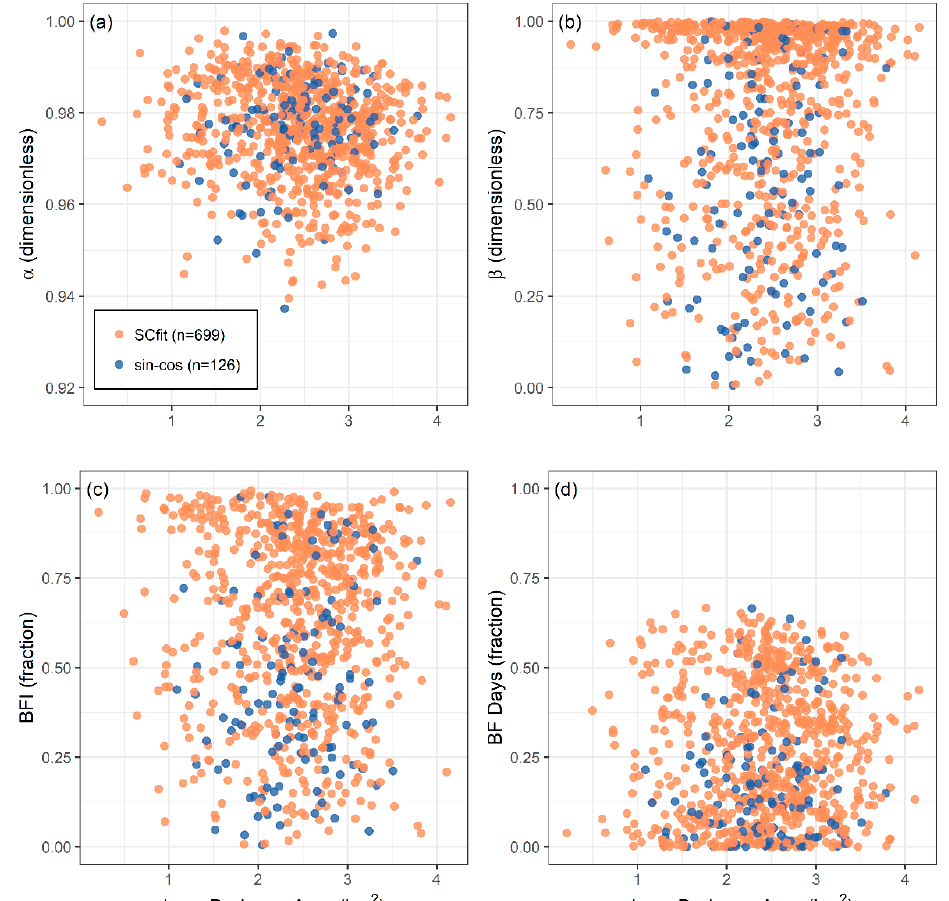
Figure 2. OHS model input parameters (( a ) α and ( b ) β ) and output variables (( c ) BFI and ( d ) BF Days) displayed by drainage area and accepted model type. BFI is the base flow index which is defined as the fraction of total streamflow attributed to base flow. BF Days is the fraction of days for which 100 percent of streamflow is attributed to base flow.